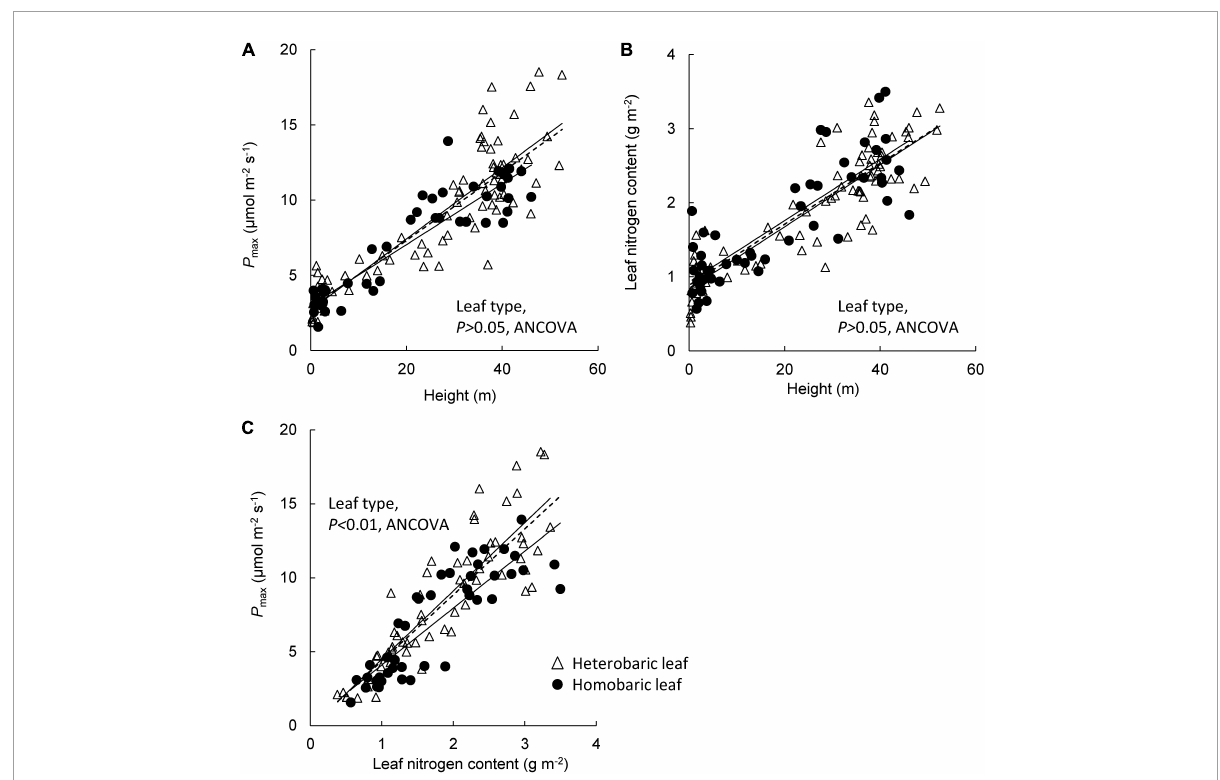
FIGURE5 Relationships of tree height with P max (A) and leaf nitrogen content (B) , and of P max with leaf nitrogen content (C) . Regression lines are as follows: (A) heterobaric leaf, r 2 = 0.77, P < 0.0001; homobaric leaf, r 2 = 0.84, P < 0.0001; (B) heterobaric leaf, r 2 = 0.77, P < 0.0001; homobaric leaf, r 2 = 0.71, P < 0.0001; (C) heterobaric leaf, r 2 = 0.77, P < 0.0001; homobaric leaf, r 2 = 0.73, P < 0.0001. Details of the results of ANCOVA appear in Appendix 9. Dotted line means regression line for pooled data for both leaf